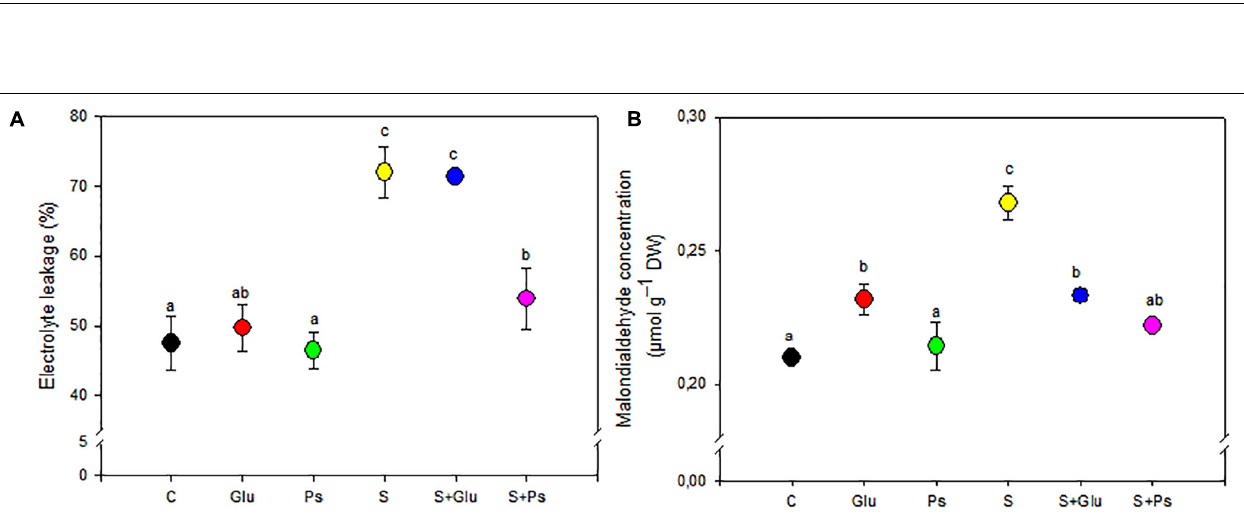
FIGURE 2 | Effect of bacterial inoculation on nutrient accumulation in shoot and root tissues of S. fruticosa (mg/g DW): (A) sodium, (B) chloride, (C) potassium, and (D) calcium, in the absence (0 mM NaCl) and in the presence of NaCl (600 mM NaCl). Values are the means standard deviation of five replicates. Values sharing the different letters indicate significant differences between treatments at the 5% level (Duncan’s).